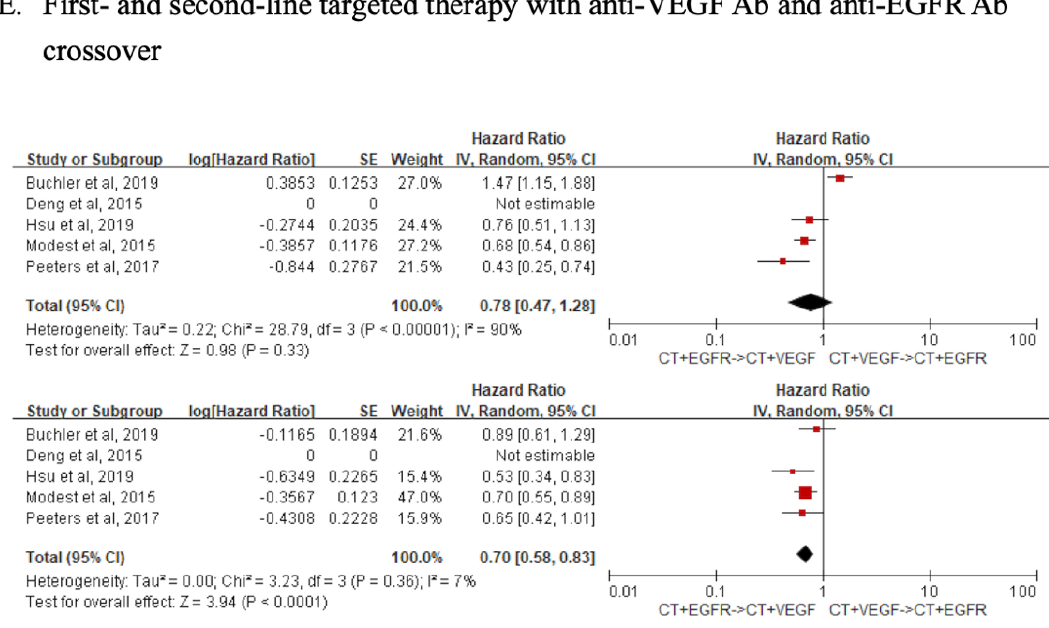
Figure 2. Effect of the different sequence regimens on the progression-free survival, overall survival, and objective response rate. ( A ) Second-line therapy of change chemotherapy (CT) and targeted agent (TG) versus change in first-line therapy with bevacizumab plus chemotherapy; ( B ) Change in second line CT and continuation of bevacizumab versus change in first-line bevacizumab plus CT; ( C ) Change in second-line CT and continuation of bevacizumab versus change CT and TG to anti-EGFR Ab in first-line bevacizumab plus CT; ( D ) Change CT and continuation of cetuximab versus change CT only in first-line anit-EGFR Ab plus CT; ( E ) First- and second-line targeted therapy with anti-VEGF Ab and anti-EGFR Ab crossover; Abbreviations: CT, chemotherapy; cCT, changed chemotherapy; TG, targeted agent; Bev, bevacizmab; SD, standard deviation; VEGF, vascular endothelial growth factor; EGFR, epidermal growth factor receptor; IV, interval variable; CI, confidence interval; Ab, antibody; M-H, Mantel–Haenszel.